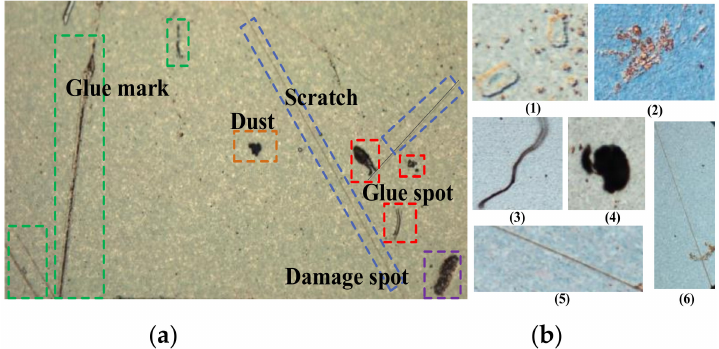
Figure 1. Challenges of detecting surface defects of metallic components. ( a ) Defects with various shapes and sizes, ( b1 ) defects with ambiguous edges and low contrast, ( b2 ) defects with different background, ( b3 ) fiber, ( b4 ) dust, ( b5 , b6 )